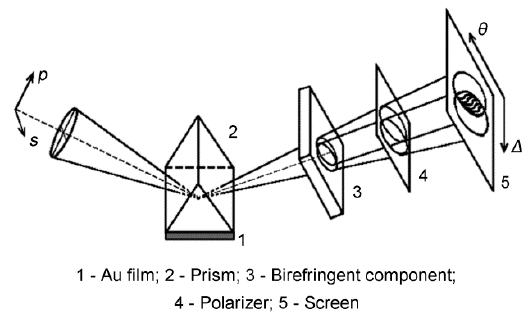
Figure 4. Shear interferometry scheme for SPR phase interrogation (Adapted from [48]).